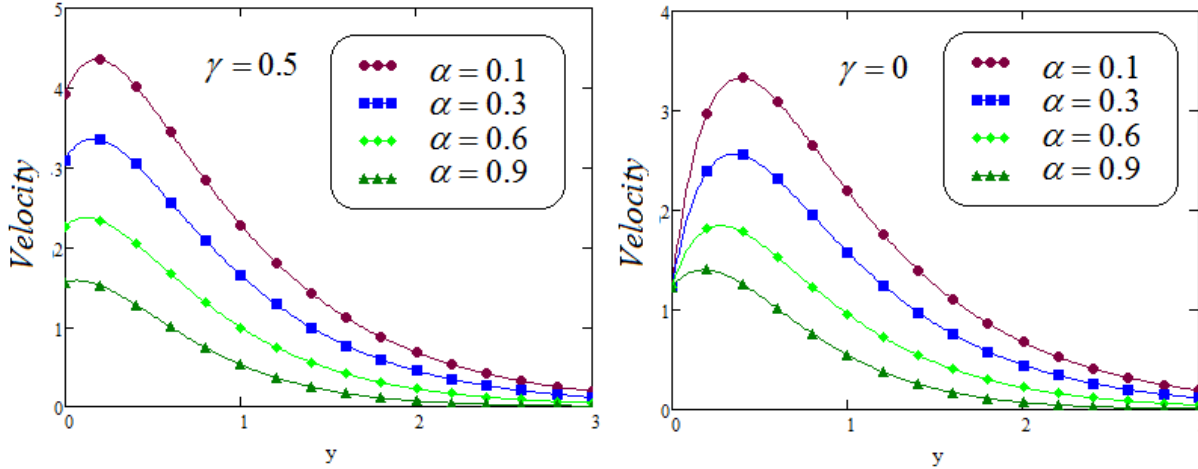
Figure 8. Velocity for varied values of α with and without slip effect γ when f ( t ) = e at , t = 1.5, β = 0.3, Gr = 3.5, M = 2, λ 1 = 0.6, λ 2 = 0.2, P r = 0.71.